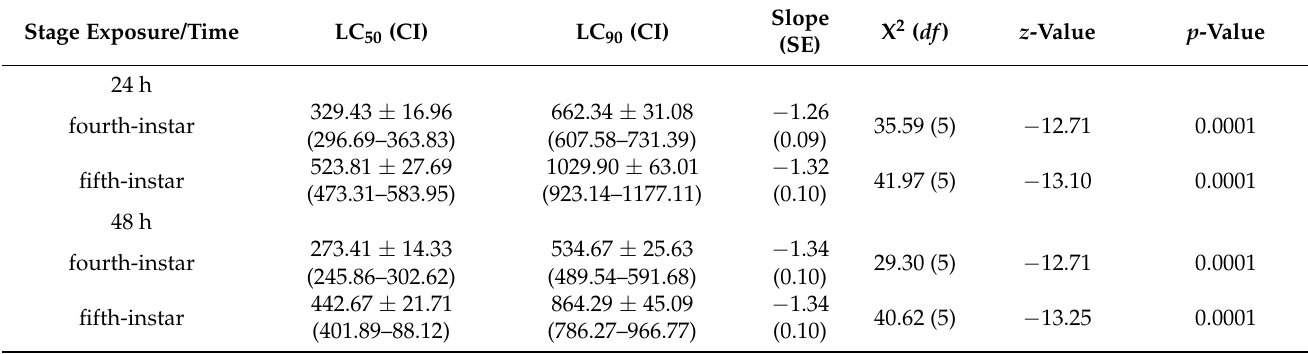
Table 3. Lethal concentrations and regression analysis of Bactericera cockerelli nymphal stages treated with Schinus molle essential oil.